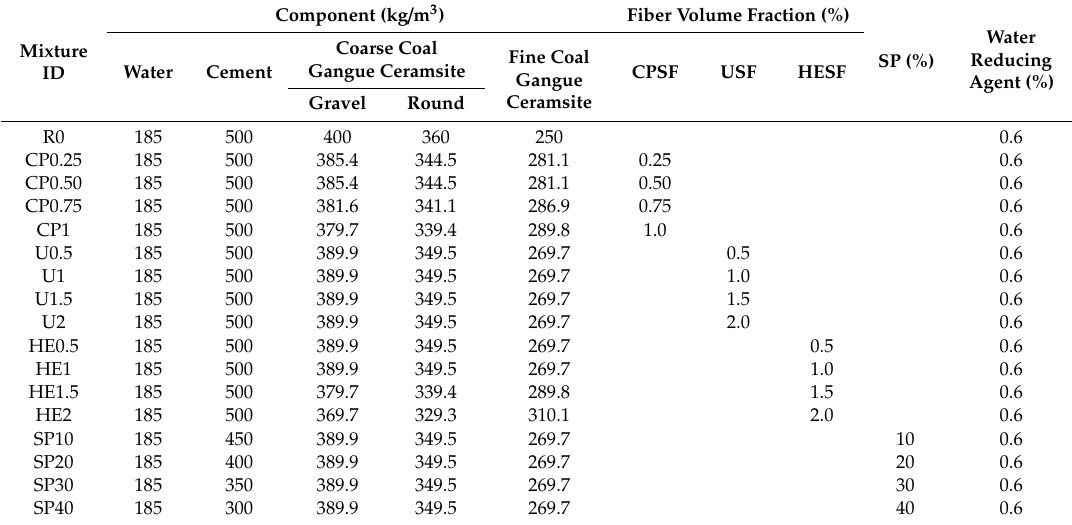
Table 6. Mixture